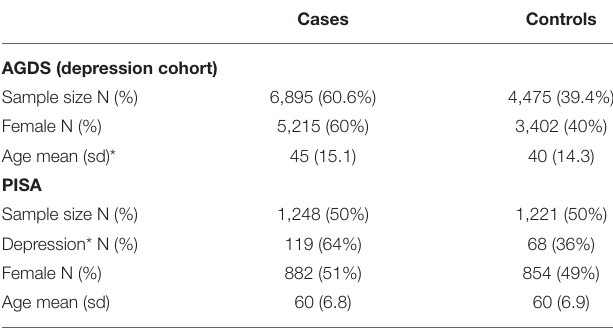
TABLE 1 | Chronic pain prevalence in AGDS and PISA cohorts.